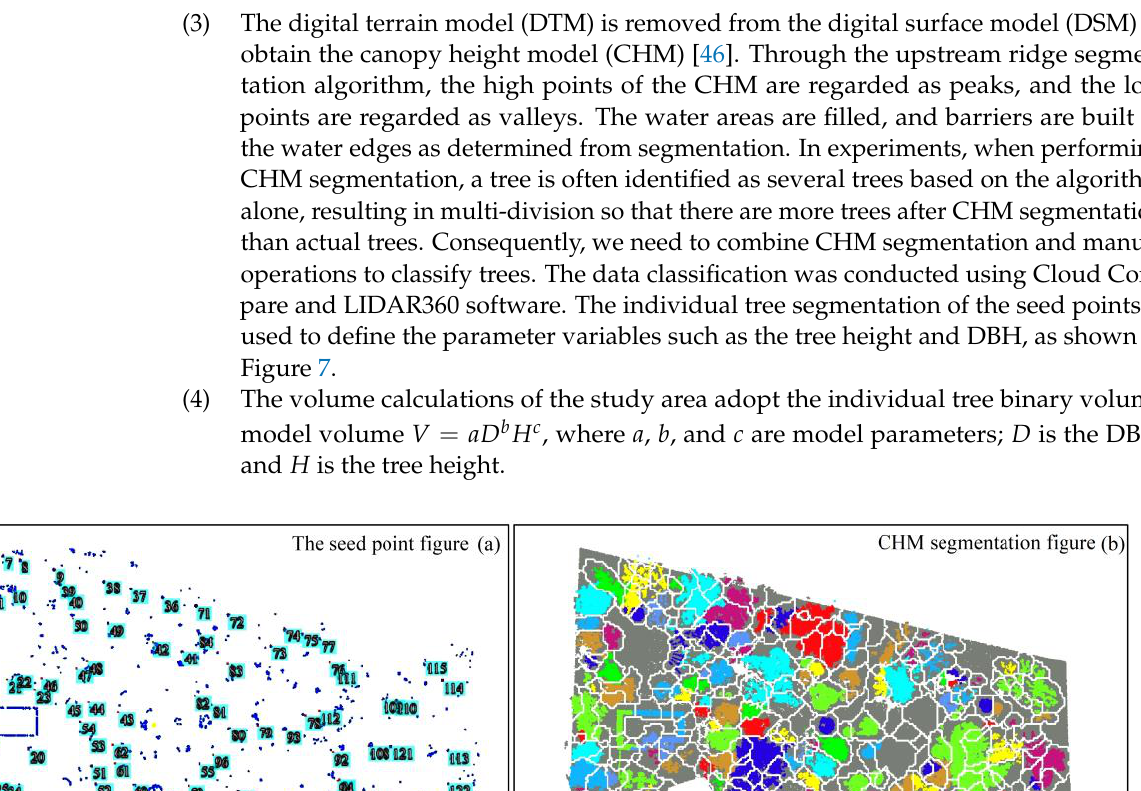
10 of 18 Figure 6. (Top): Multispectral classification data; (Bottom) Point-cloud data. Calculation of Individual Tree Biomass of Classified Tree Species After tree species classification, the individual tree parameters can be extracted from